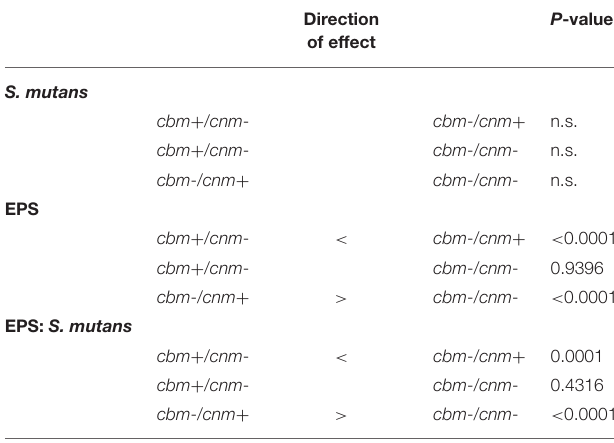
TABLE 4 | Pairwise comparisons of the effects of genotype on S. mutans , EPS and EPS: S. mutans ratio in biofilm as measured by CLSM in pixels. Direction of